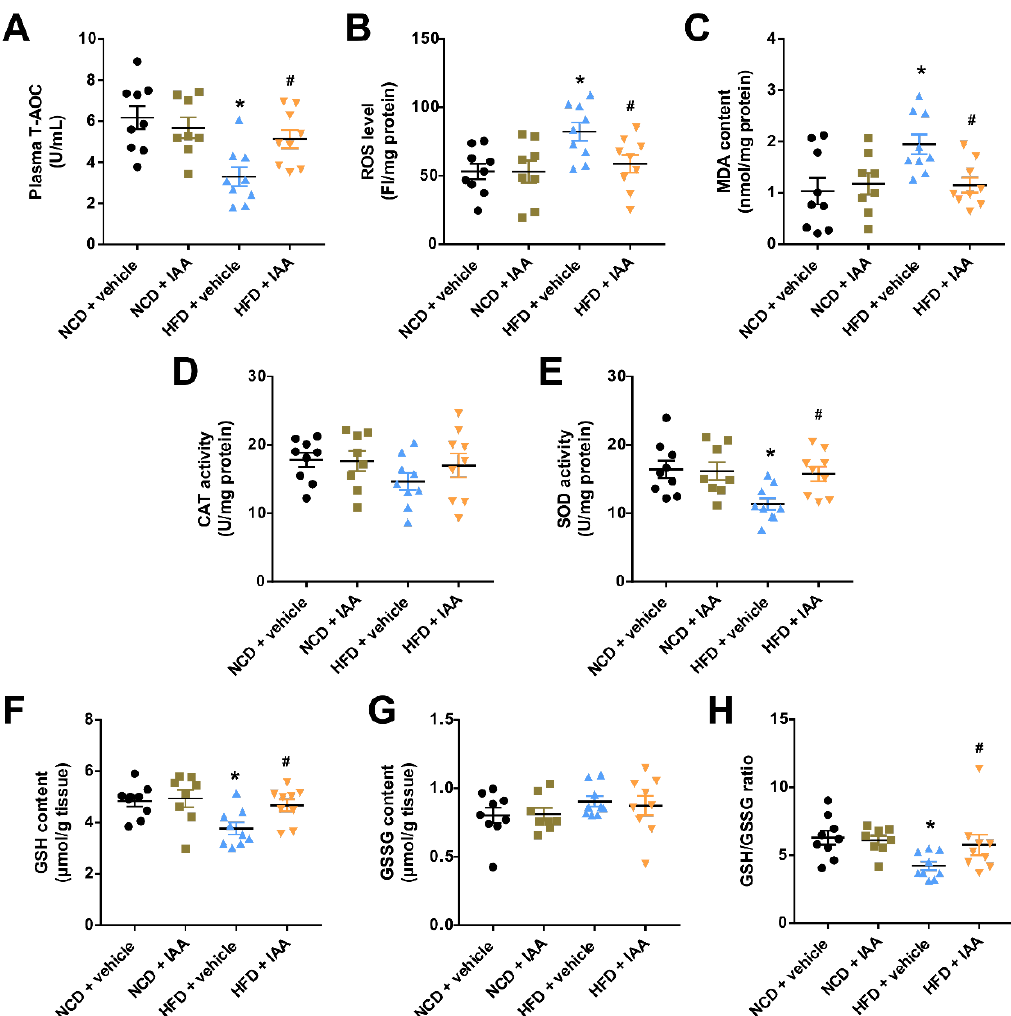
Figure 5. Changes in oxidative stress markers in mice exposed to high-fat diet (HFD) and indole-3-acetic acid (IAA) treatment. ( A ) plasma total antioxidant capacity (T-AOC), ( B ) and ( C ) liver reactive oxygen species (ROS) and malondialdehyde (MDA) level, F, fluorescence intensity. ( D , E ) liver superoxide dismutase (SOD) and catalase (CAT) activity. ( F , G ) the content of glutathione (GSH) and oxidized glutathione (GSSG), and ( H ) the ratio of GSH / GSSG. Values are shown as the mean ± standard error of the mean. * p < 0.05 vs. NCD + vehicle; # p < 0.05 vs. HFD + vehicle.